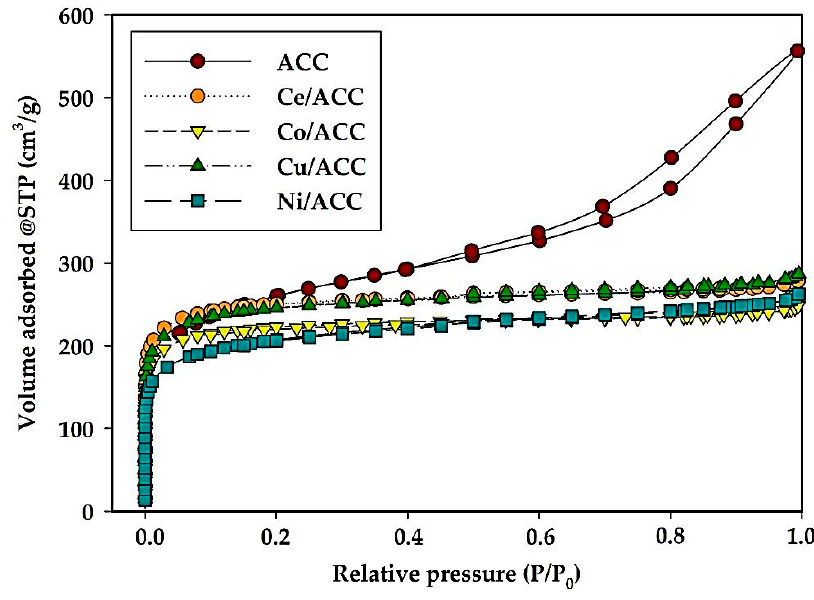
Figure 1. Adsorption-desorption isotherms of catalysts at − 196 °C.